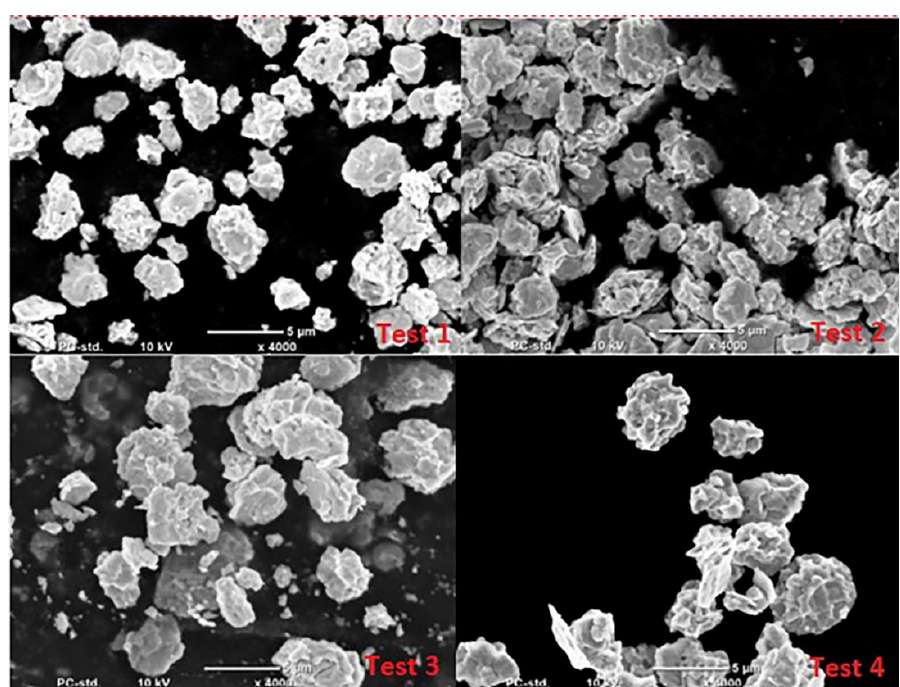
Figure 12. Structure of lead oxide obtained under conditions of high humidity of air fed to the reactor.